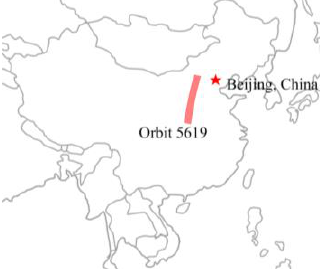
Figure 3. The distribution of the experimental images